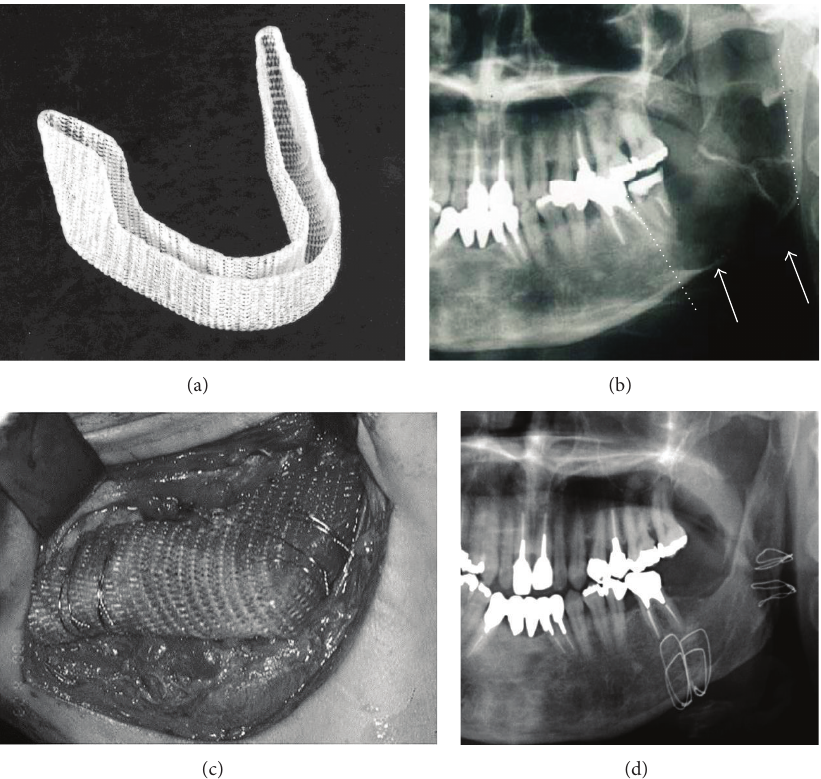
Figure 5: Regeneration of the jaw using PLLA mesh and PCBM [163]. (a) PLLA mesh tray and (b) keratocystic odontogenic tumor of the left mandible, preoperative panoramic X-ray. Multilocular radiolucent area (arrow) and segmental resection line (dotted line). (c) Reconstruction using the PLLA mesh tray and PCBM and (d) X-ray image 1 year and 586 months after the reconstructive surgery. Formation of the matured regenerated bone and mandibular